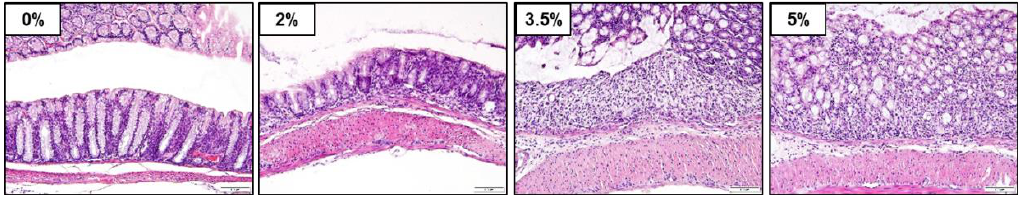
Figure 2. Histopathological analysis of the colon of the DSS-induced colitis mouse model. Colon tissues were stained with H&E (200 × magnification).